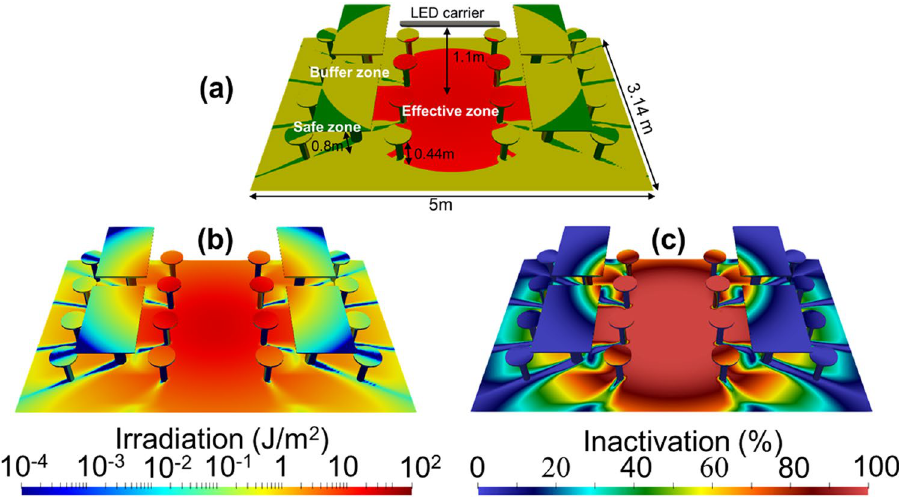
Figure 6. ( a ) The schematic feature of a typical food court in Singapore where the LED array (shown in Fig. 5a) is located in the center of the food court and 1.1-m from the ground. The zone map is defined ( b ) 3D irradiation mapping of the food court after a 30-s UV-C exposure, and the corresponding inactivation of SARS-CoV-2 evaluated from Eq. (3) is shown in ( c ).